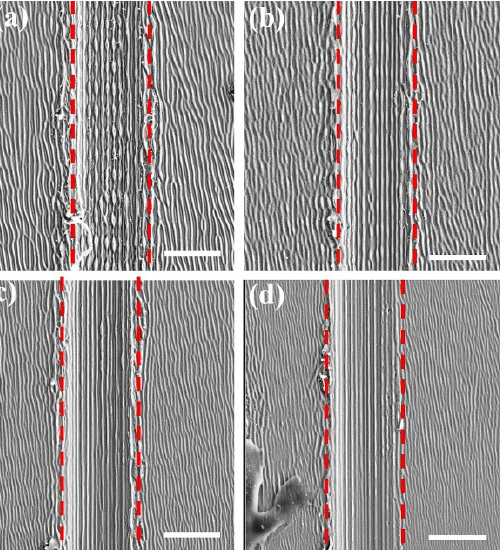
Figure 7. Observed evolution of the laser-induced structure morphology with different total incident laser fluences. ( a ) 48 mJ/cm 2 , ( b ) 46 mJ/cm 2 , ( c ) 42 mJ/cm 2 , and ( d ) 40 mJ/cm 2 . Scale bar: 2 μ m.